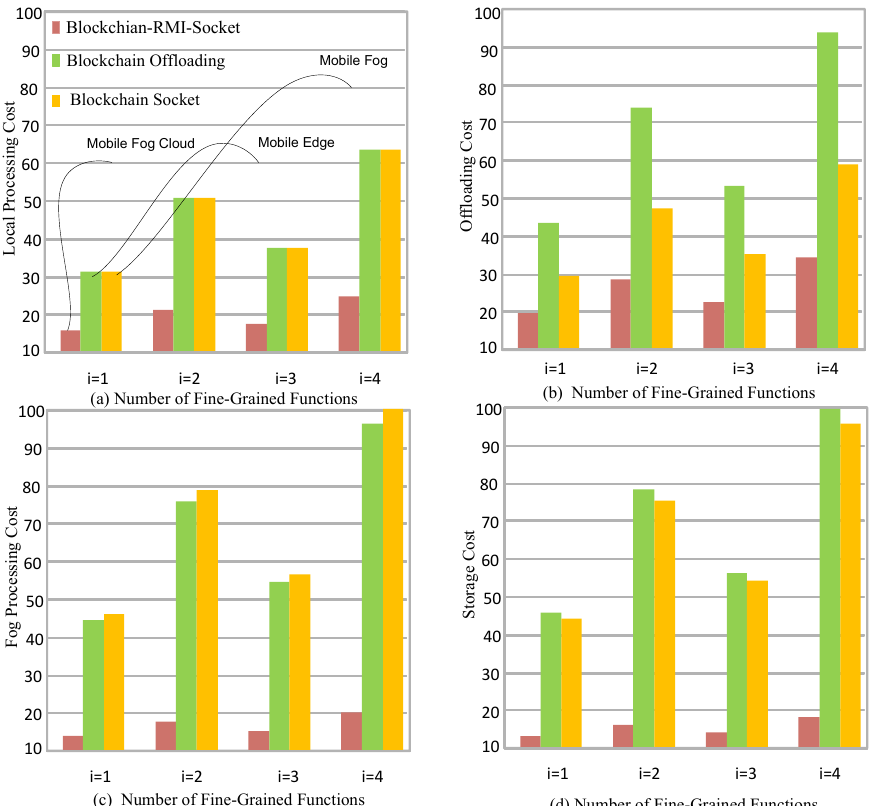
Figure 5. Cost-Efficient RMI-Socket-Blockchain System for Healthcare Functions in a Mobile-Fog- Cloud